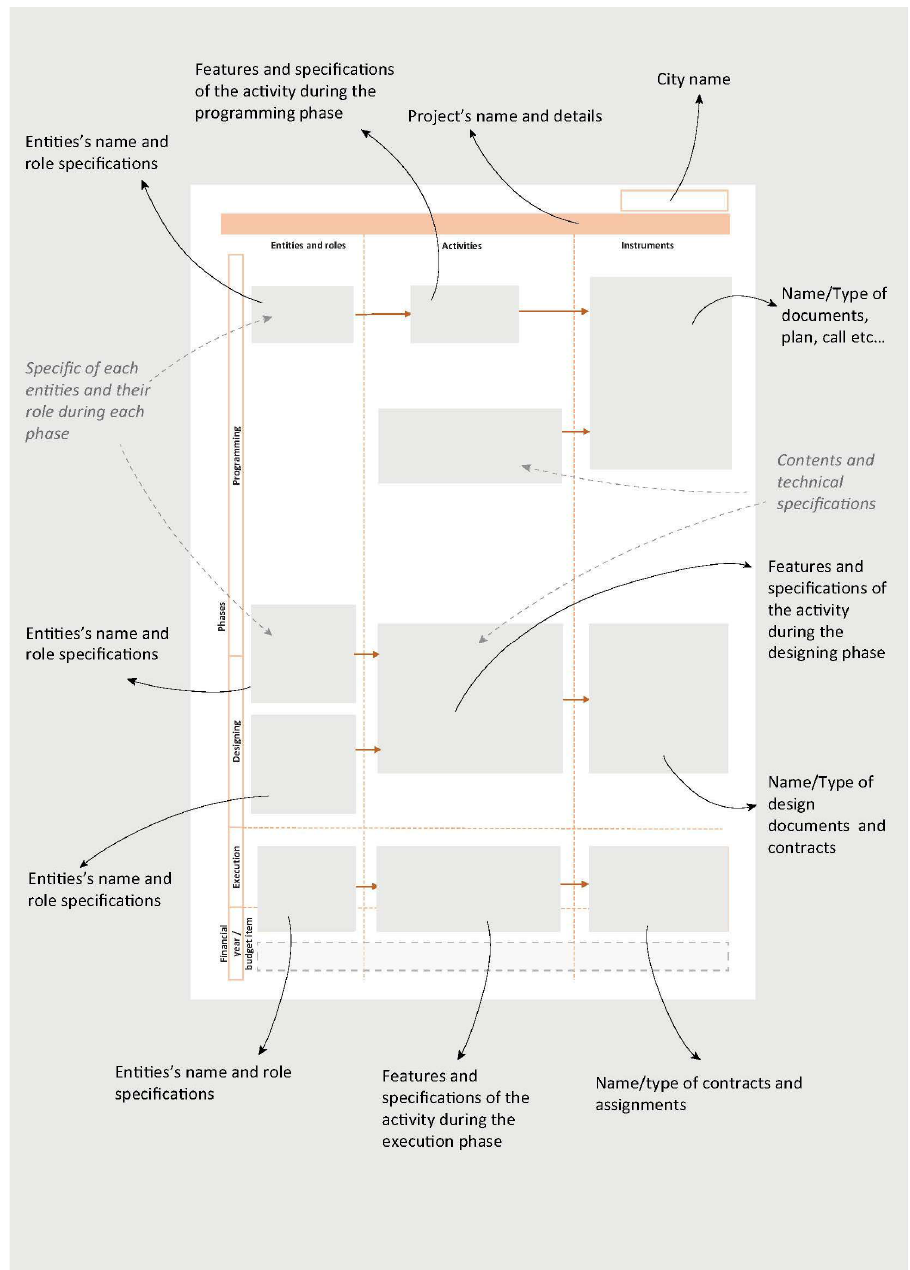
Figure 3. An example of a case-study project intervention sheet and the implementation